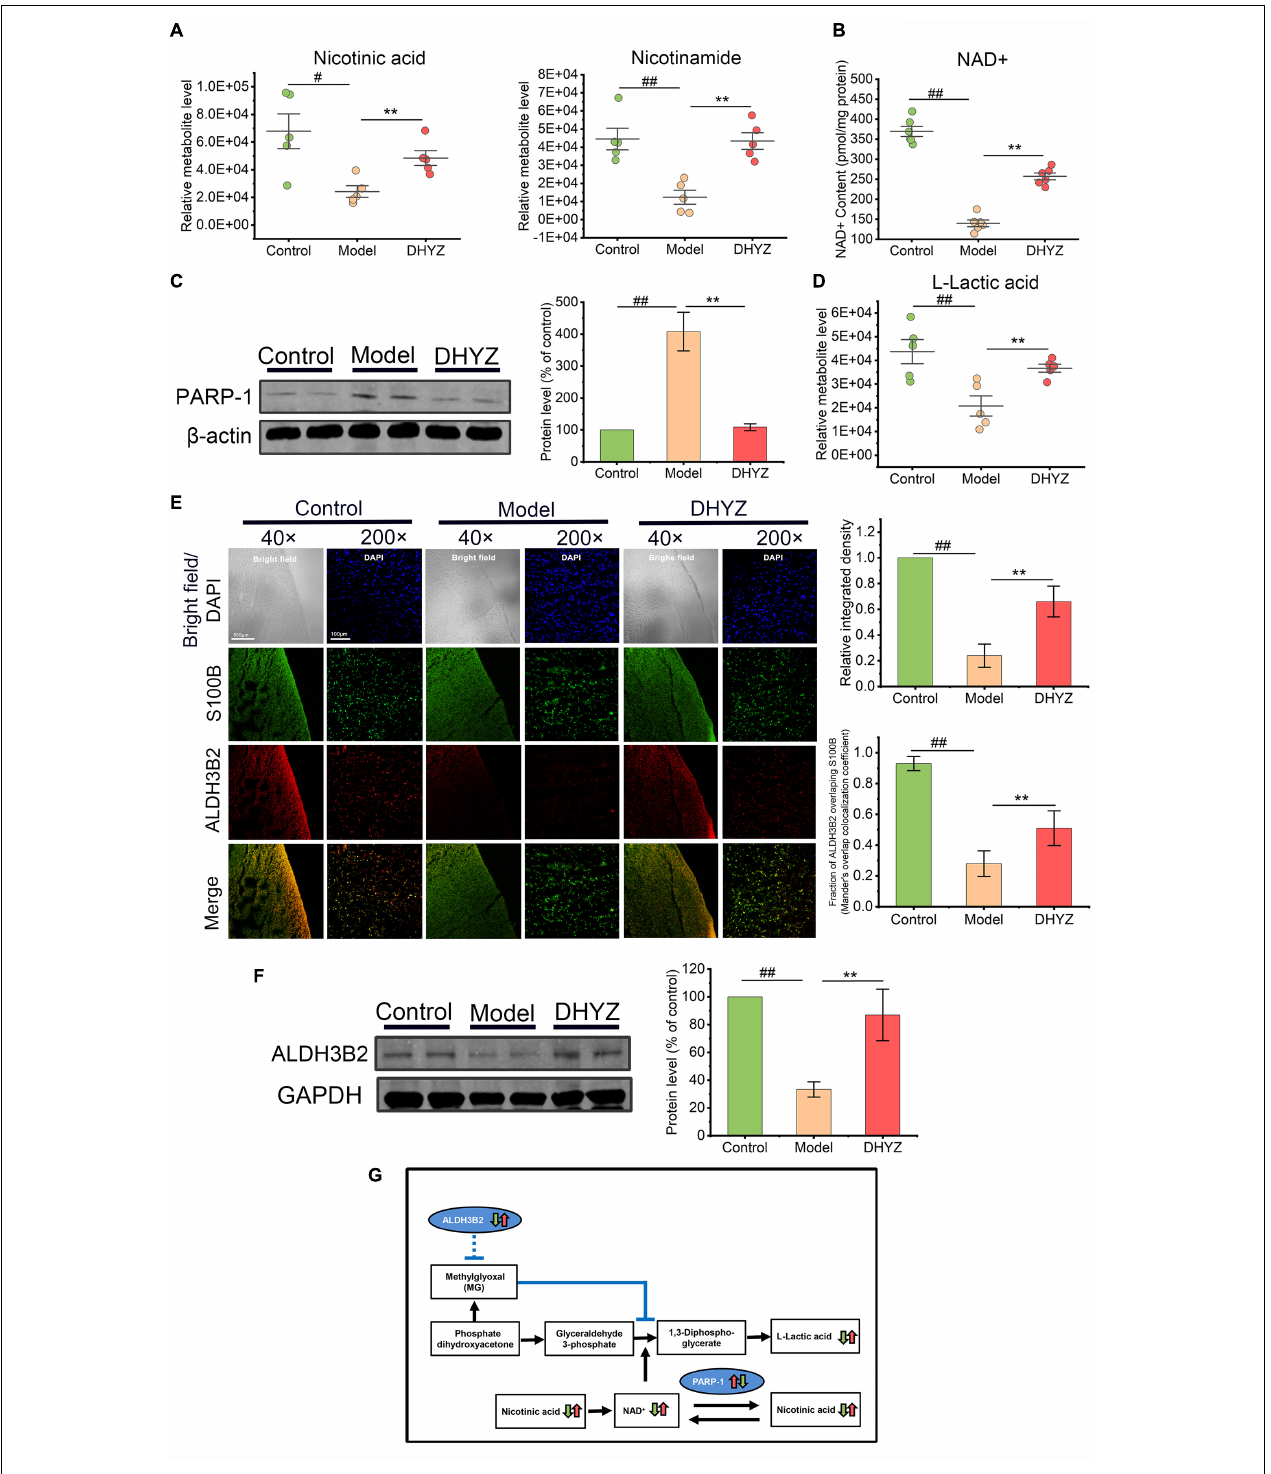
FIGURE 8 | The preservation effects of DHYZ on nicotinate and nicotinamide Metabolism and glycolysis. (A) Metabolomics analysis illustrating the relative levels of urine nicotinic acid and nicotinamide ( n = 5). (B) The scatter dot plot diagram of the level of NAD + in the brain of mice in three groups was determined by photochemical assay ( n = 6). (C) The protein level of PARP-1 was measured by western blot analysis ( n = 3). (D) The relative level of urine L-lactic acid as illustrated in metabolomics analysis ( n = 5). (E) Representative images of immunofluorescence staining of ALDH3B2 (Red, Alexa Fluor R (cid:13) 594) and S100B (Green, FITC) ( n = 5 mice per group; magnification × 40, scale bar = 500 µ m; × 200, scale bar = 100 µ m); the corresponding histogram of ALDH3B2 relative intensity in mouse cerebral